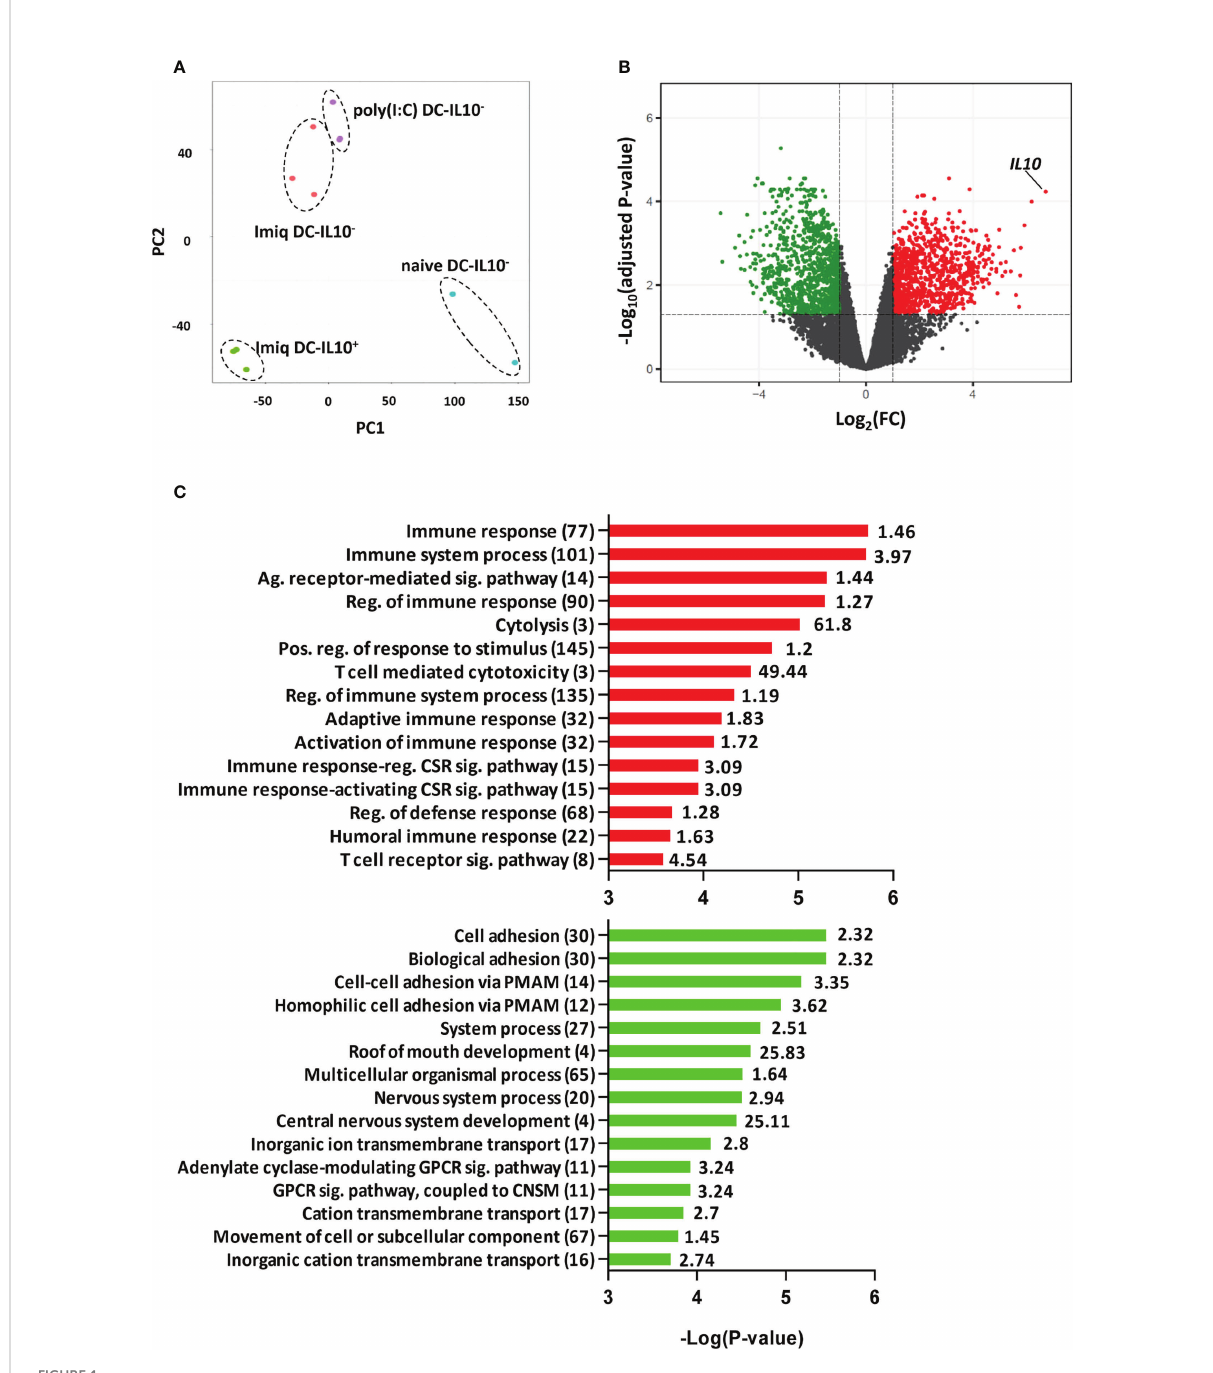
FIGURE 1 DC IL-10 + have a different transcriptomic pro fi le. Splenic DC from Vert-X mice (naïve or immunized with OVA + Imiquimod or poly(I:C) adjuvants) pooled from 10-20 mice/group, were puri fi ed according to their IL-10 production pro fi le and subjected to RNAseq experiments. (A) Principal component analysis (PCA) of the different treatment DC groups. (B) Volcano plot showing DEGs between DC IL-10 + and DC IL-10 - obtained from Imiquimod vaccinated mice. Colored dots represent signi fi cant (FC>2, adjusted P <0.05) DEGs between groups, with green dots representing down-regulated genes and red dots up-regulated genes in DC IL-10 + . (C) Most signi fi cantly enriched GO terms in up-regulated and down-regulated genes according to Panther. Values in brackets indicate the number of genes classi fi ed under a particular GO term, with the enrichment value shown to the right. (Ag, Antigen; Sig, Signaling; Reg, Regulation; Pos, Positive; CSR, Cell Surface Receptor; PMAM, Plasma Membrane Adhesion Molecule; GPCR, G protein-coupled receptor; CNSM, Cyclic nucleotide second